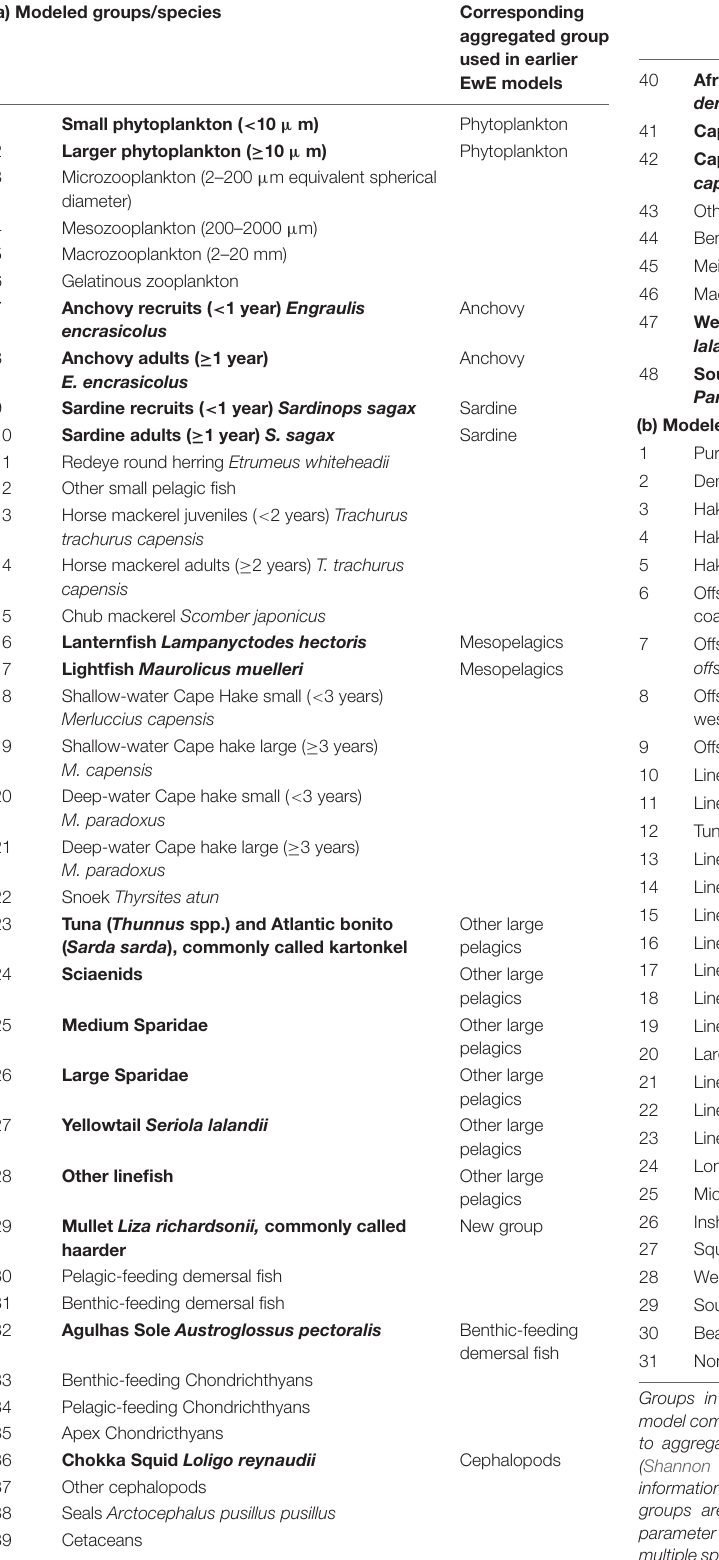
TABLE 1 | Revised species and fishing fleet aggregation: (a) species groups and (b) fishing fleets modeled. (a) Modeled